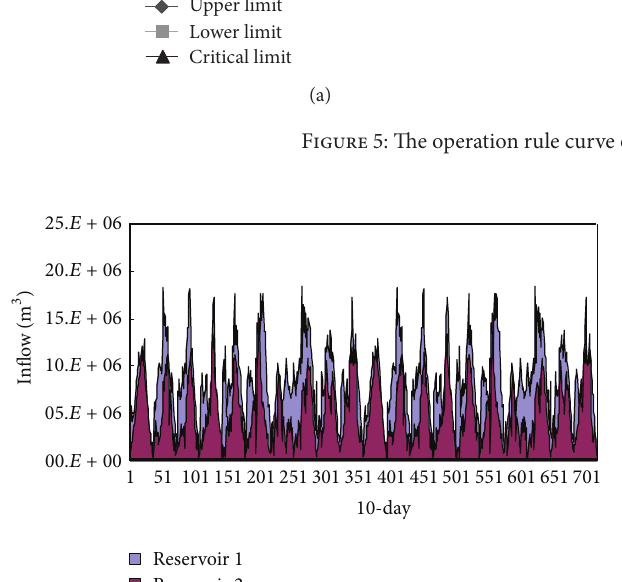
Figure 6: Reservoir inflows in surface water system.